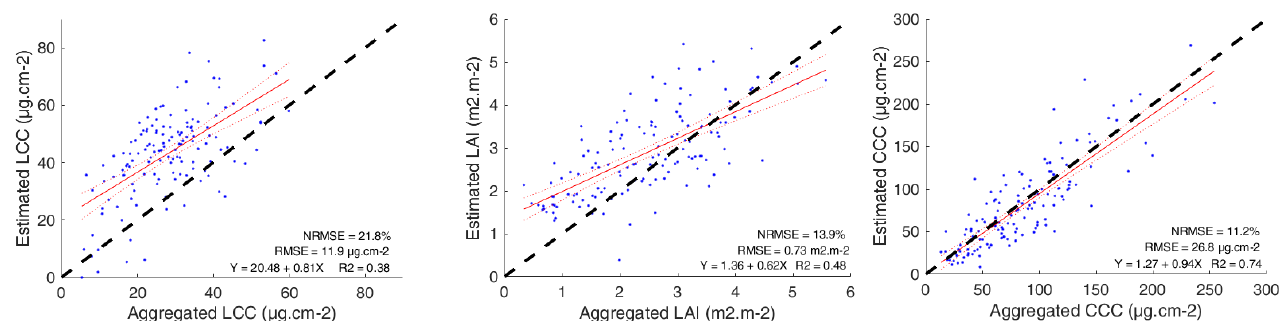
Figure 5. Validation of the OLCI vegetation products at a moderate scale. Estimated values were generated by applying the OLCI retrieval models to a S3-OLCI subset. Measured values were obtained by aggregating the fine-scale estimations retrieved from Hyplant* to the 300 m spatial resolution of S3-OLCI.